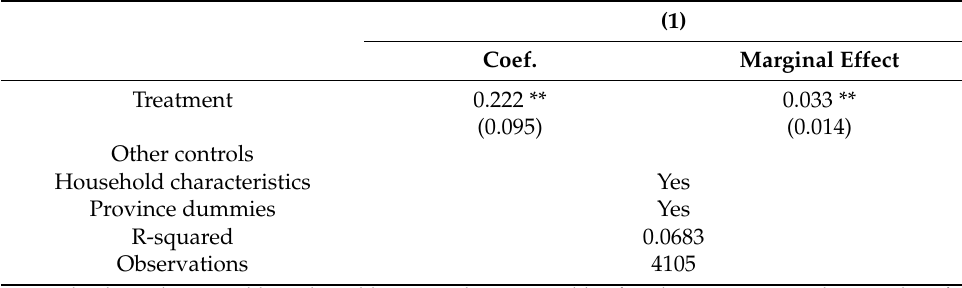
Table 4. Robustness check: PSM.